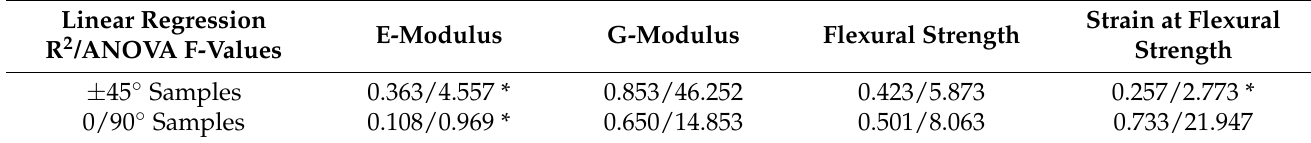
Figure 9. Correlation of flexural stresses ( a ) and strains ( b ) to average ACU damping of bending bars (relative values). A significant correlation is found irrespective of sample orientation ( a ), whereas strains are correlated to ACU damping only for 0/90 ◦ samples ( b ). Table 3. ANOVA-type analysis with R 2